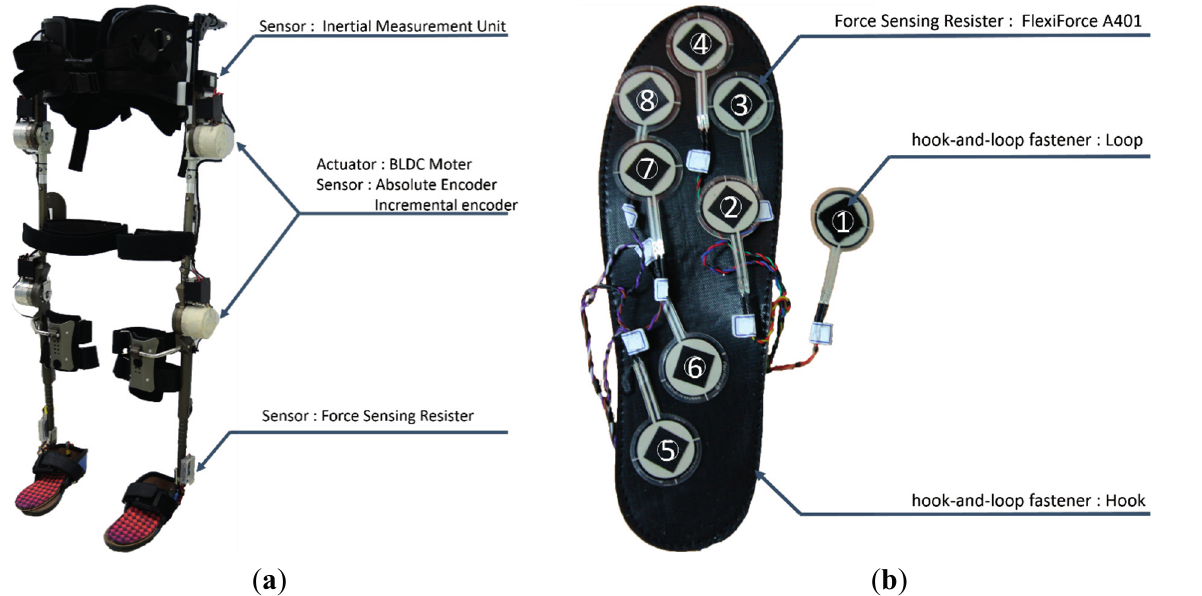
Figure 1. The appearance and sensor configurations of ROBIN-H1. ( a ) ROBIN-H1 lower limb exoskeleton robot and its hardware configuration; ( b ) Insole-type foot sensor configuration. Eight FSRs are inserted between the upper and lower insoles. The placement of each FSR is determined and adjusted according to the foot size and shape of the wearer before using the